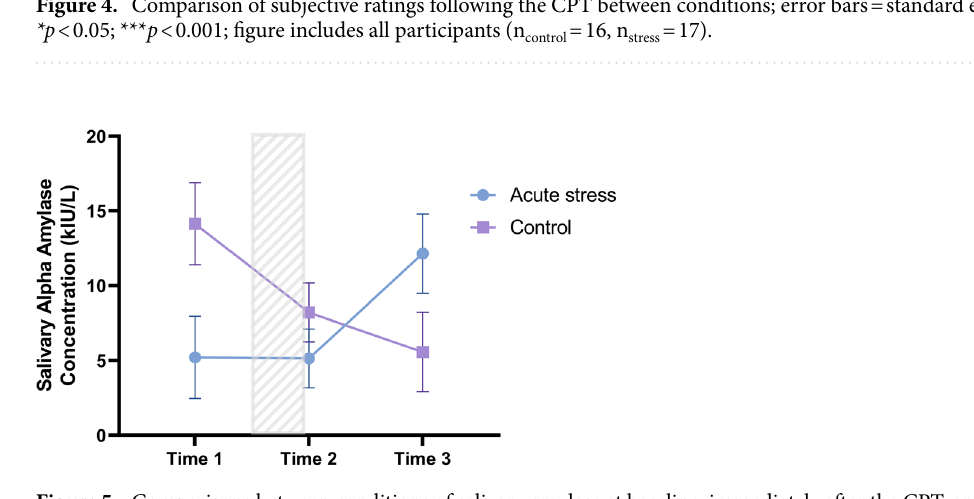
Figure 5. Comparisons between conditions of salivary amylase at baseline, immediately after the CPT, and after completion of the Wisconsin Card Sorting task; figure includes all participants (n control = 16, n stress = 17); error bars = standard